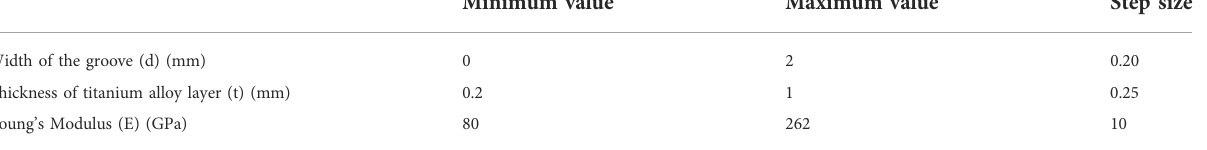
TABLE 1 Parameter range for the optimization of a sandwich composite metal locking